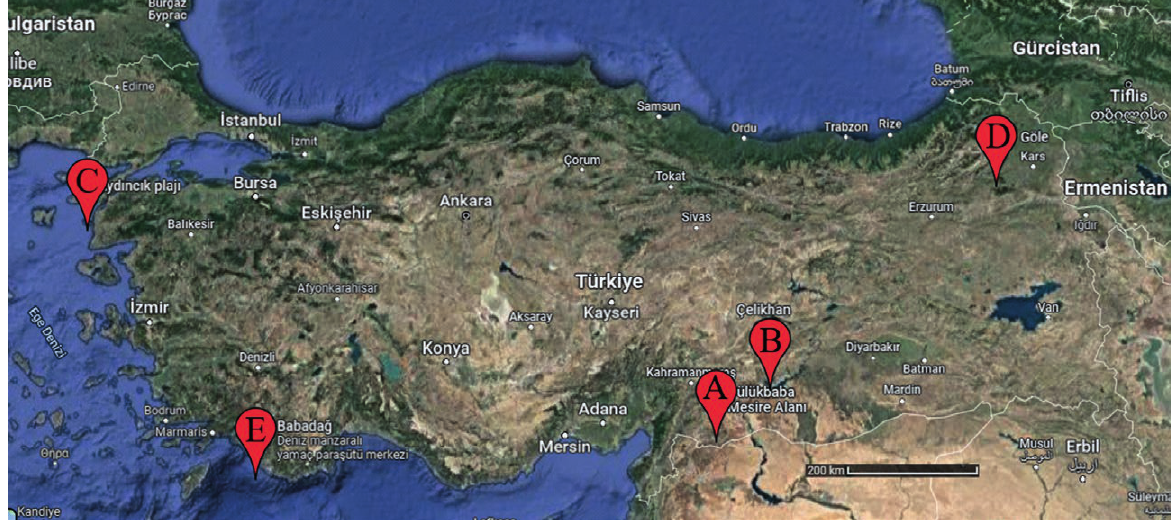
Figure 2. Distribution map of the studied species in Turkey. (A) S. aintabensis ; (B) S. boissieri ; (C) S. icarica ; (D) S. macrantha ; and (E) S. spinosa